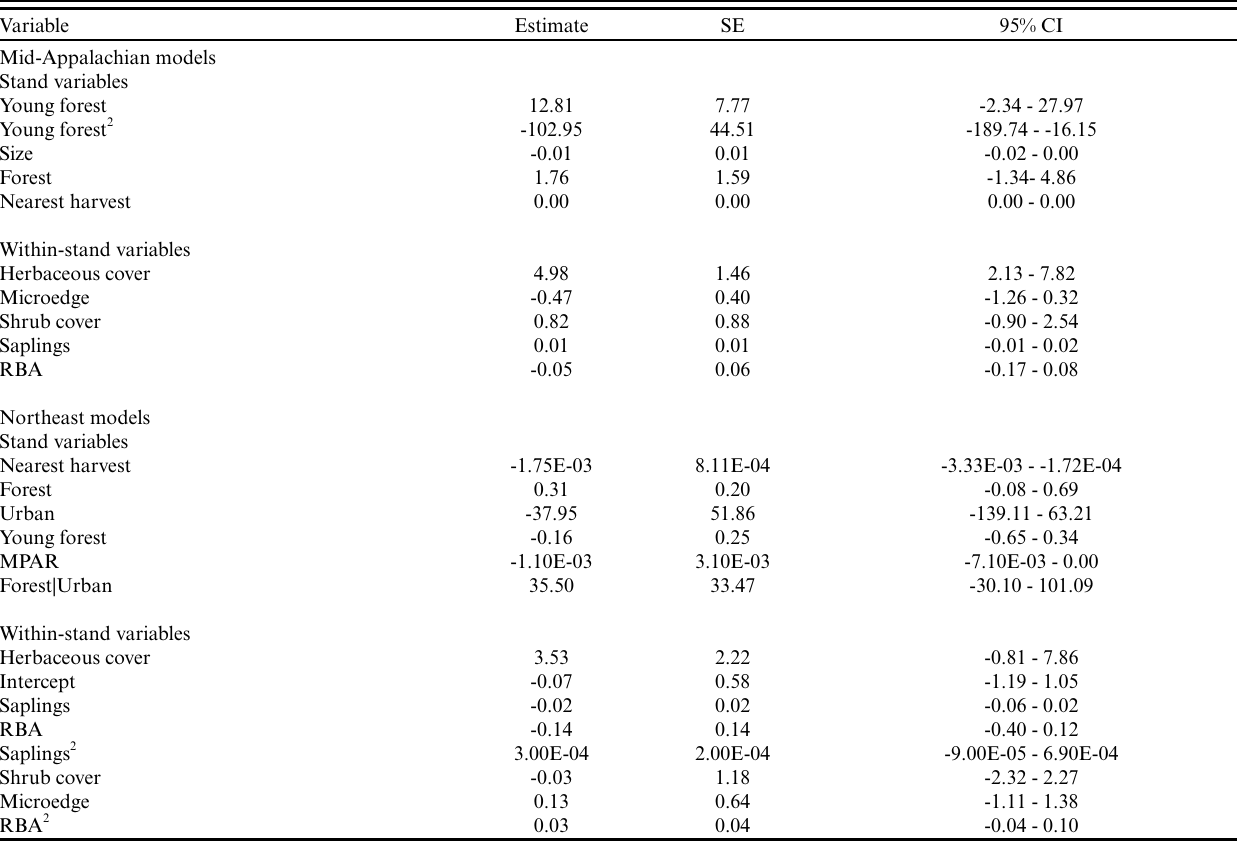
Table 3 . Predictor variables and model-averaged parameter estimates, standard errors (SEs), and 95% confidence intervals (CIs) included in models hypothesized to affect Golden-winged Warbler ( Vermivora chrysoptera ) apparent abundance at mid-Appalachian and northeast regional scales using stand and within-stand variables for regenerating stands in Pennsylvania and western Maryland, 2010-2011. Only the variables from the confidence set of candidate models are included. See Appendix 1 for explanations of terms used in